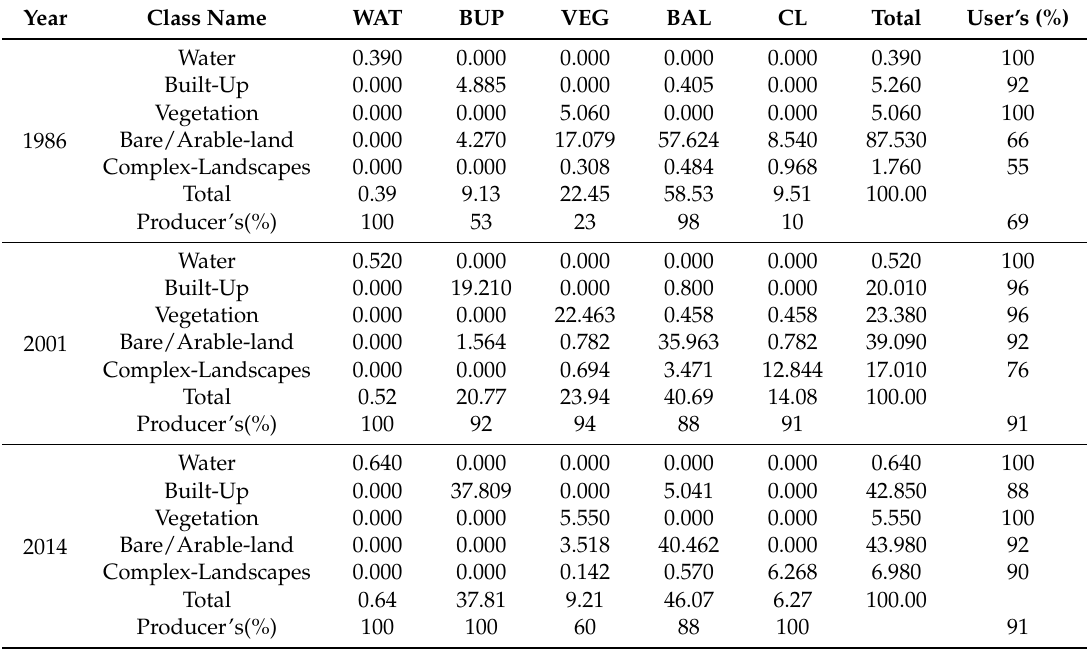
Table 6. Error adjusted matrix of LULC Maps of 1986, 2001 and 2014. WAT: Water; BUP: Built-Up; VEG: Vegetation; BAL: Bare/Arable Land; CL: Complex